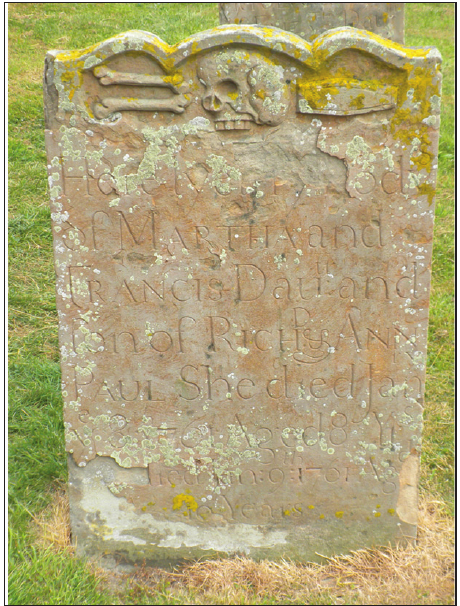
Figure 3: Skull with unidentifiable limb bones and a coffin. All Saints Church, Cottenham,